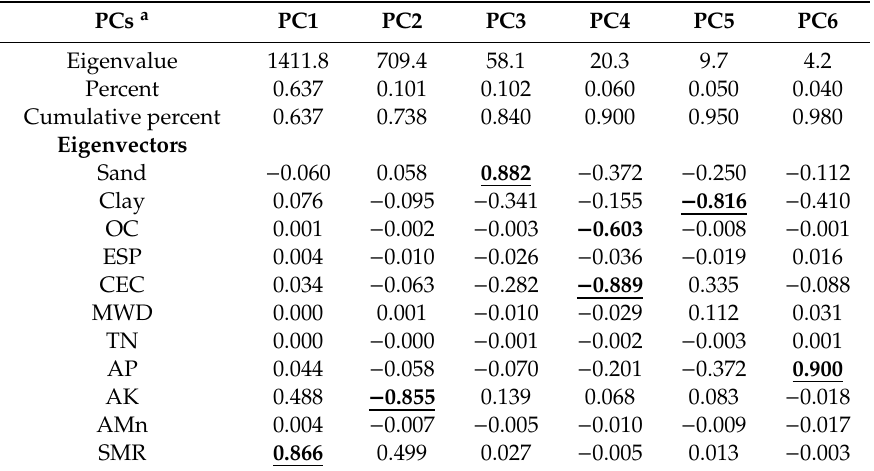
Table 4. Results of principal component analysis (PCA) for soil properties.